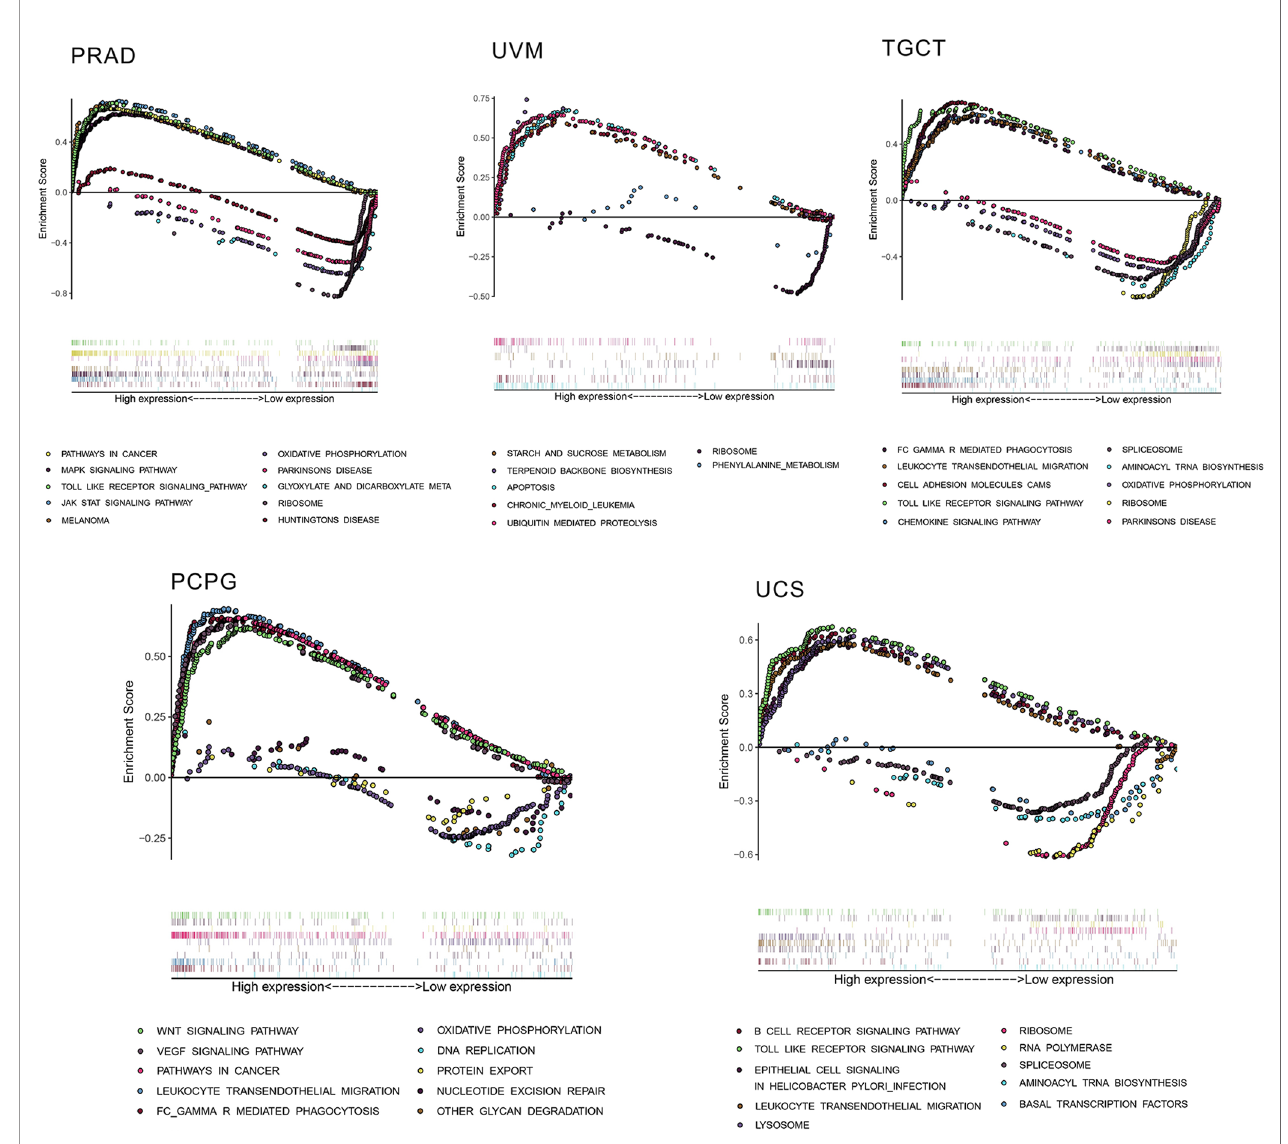
FIGURE 9 | The results of GSEA based on KEGG database. In each panel, the pathways marked in the left were enriched in the high AhR expression group, while the pathways marked in the right were enriched in the low AhR expression